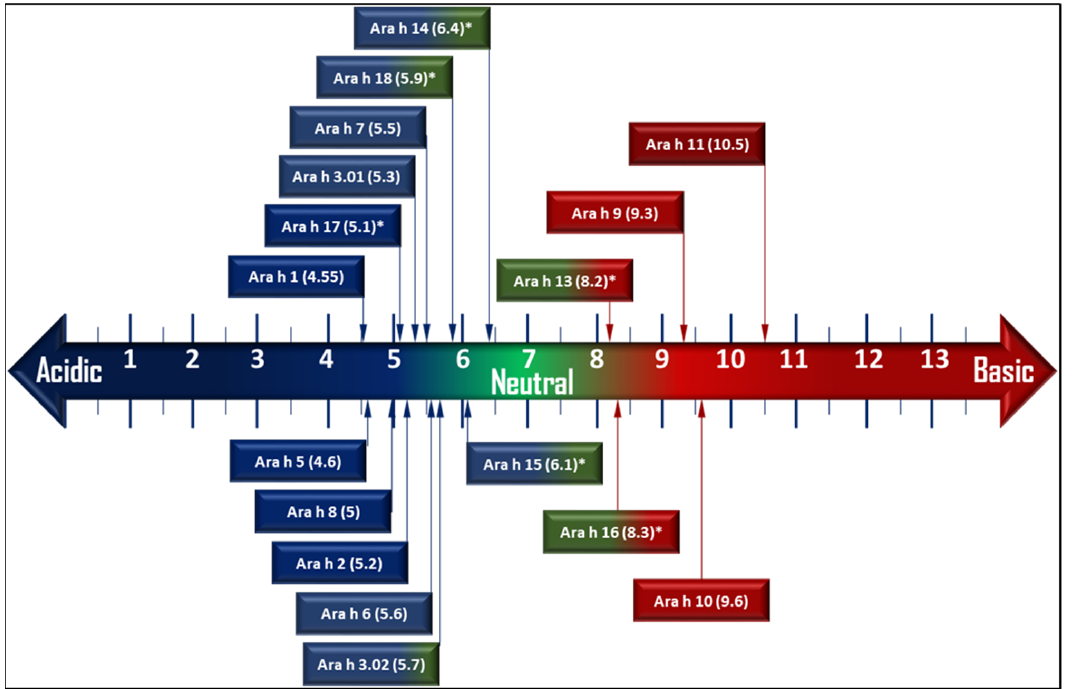
Figure 2. Distribution of pI of all peanut allergens on the pH scale. (pI values marked with * are estimations deduced from the literature studying SDS – PAGE of peanut allergens).